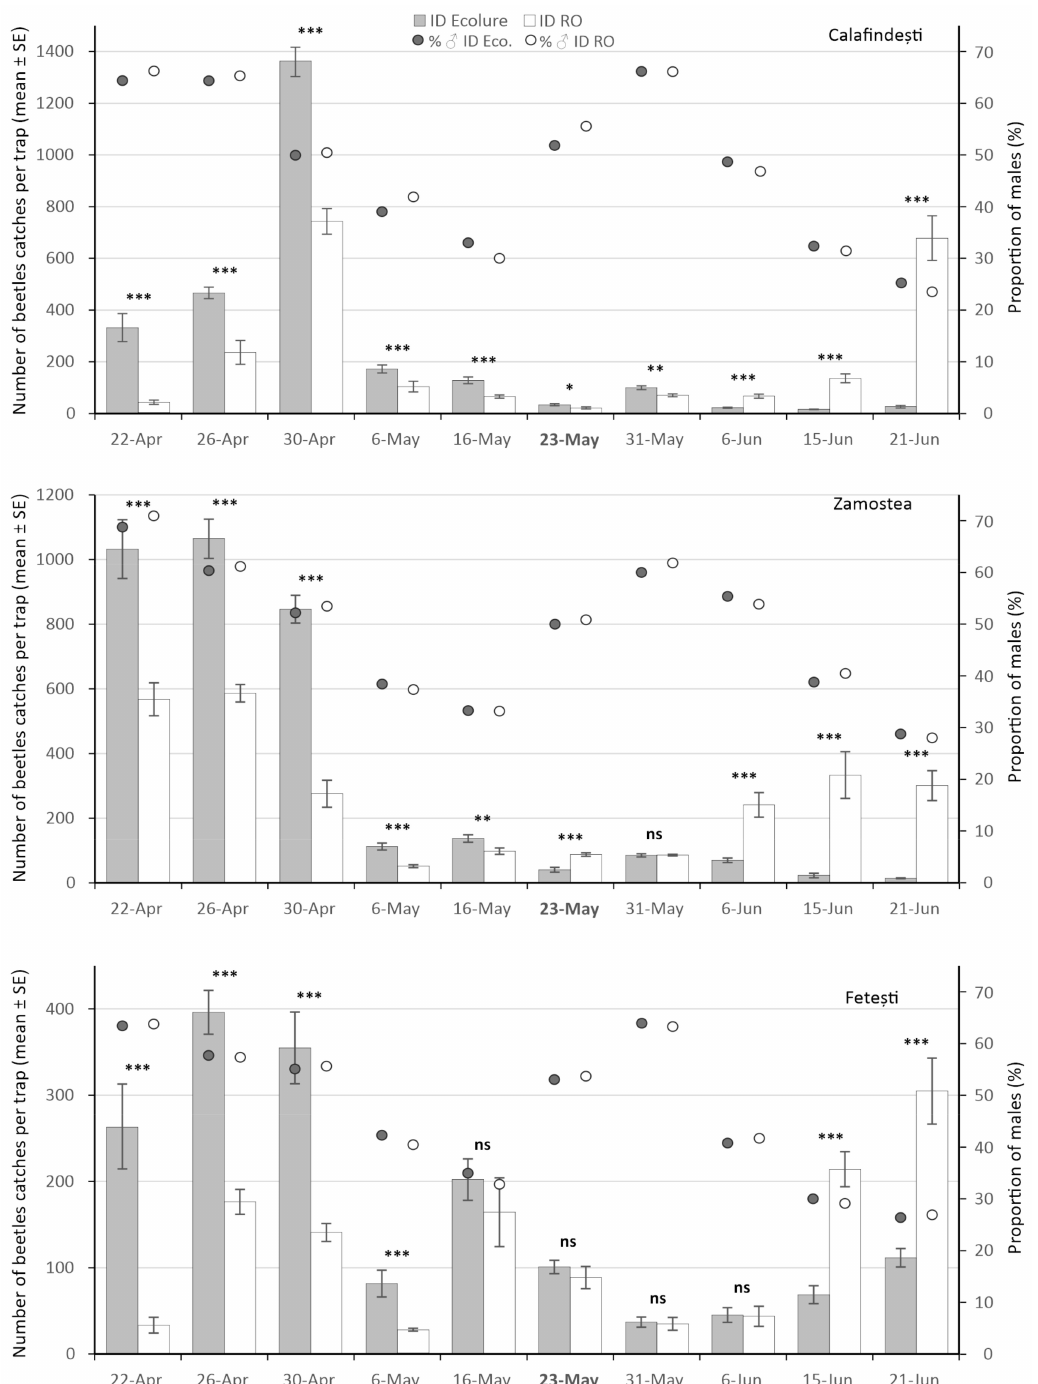
Figure 5. Dynamics of Ips duplicatus captures obtained during first field experiment (2011—Romania) at traps baited with ID Ecolure and ID RO dispenser types (mean captures: columns, reported at left Y axes, the proportion of males: dots, reported at right Y axes). The symbols above the error bars indicate the significance of the differences between the release rates according to t -test [ns—not statistically significant ( p > 0.05); *—significant ( p < 0.05); **—highly significant ( p < 0.01); ***—very highly significant ( p <